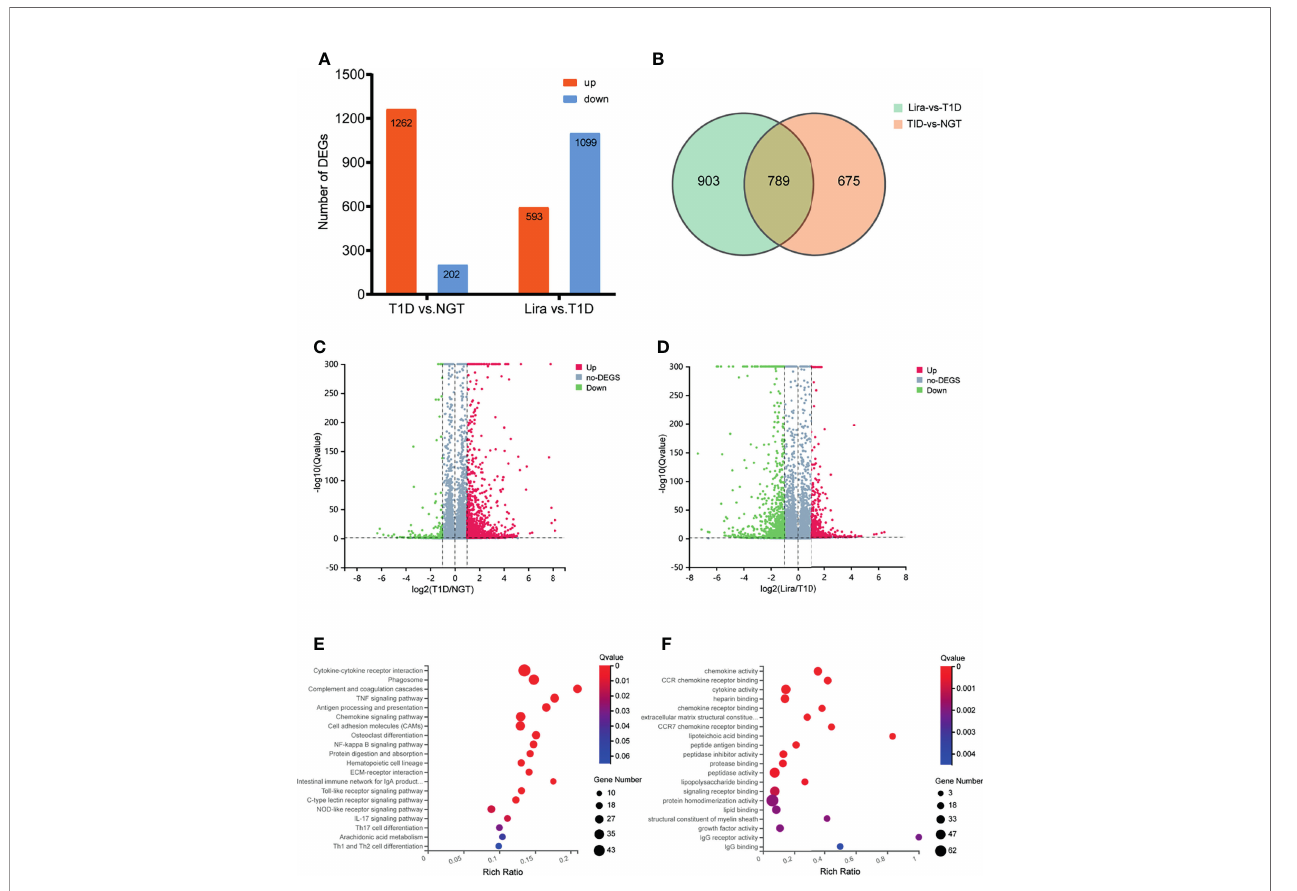
FIGURE 7 | Transcriptomic analysis of DEGs between NGT, T1D, and liraglutide treatment groups. (A) Number of DEGs in histogram; (B) Venn diagram of pairwise comparison; (C) volcano map of DEGs between the NGT and T1D groups; (D) volcano map of DEGs between the T1D and liraglutide groups. (E) Bubble plots using the KEGG database; (F) bubble plots using the GO-MF database. NGT, normal glucose tolerance group; T1D, type 1 diabetes group; Lira, liraglutide treatment group.